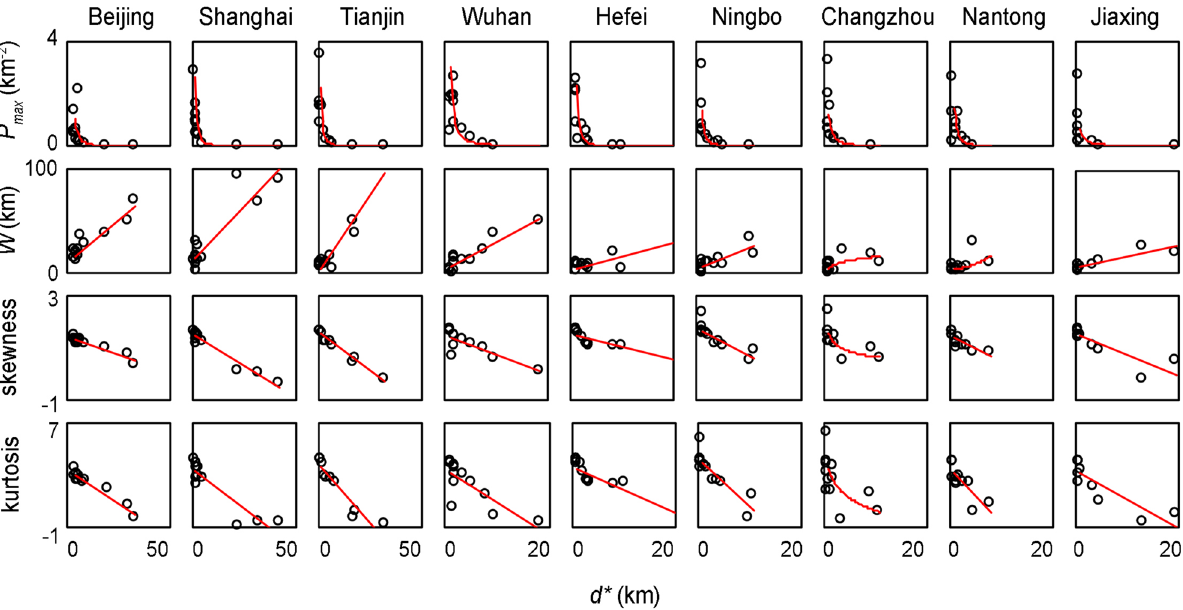
Figure 4. Relationship between d* and the other characteristic values ( P max , W , skewness, and kurtosis) of the density distribution curves of the city functional components. The red line indicates the results of correlation analysis of the scatter points in the figure, all p-values <